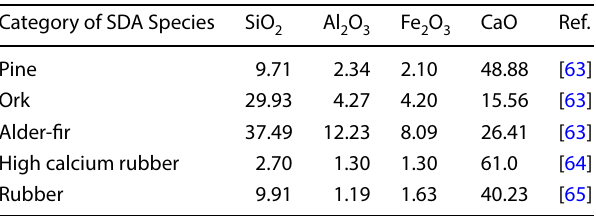
Table 2 Basic Oxides in SDA from several types of wood